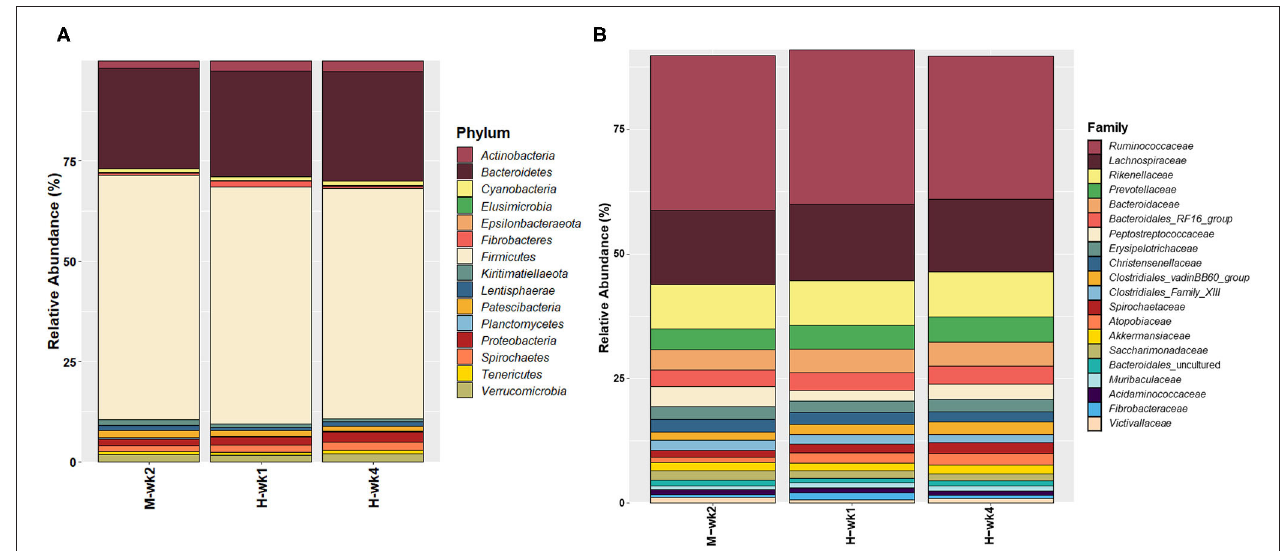
FIGURE 5 | Overall microbiota composition, given by the most abundant (A) phyla and (B) families.